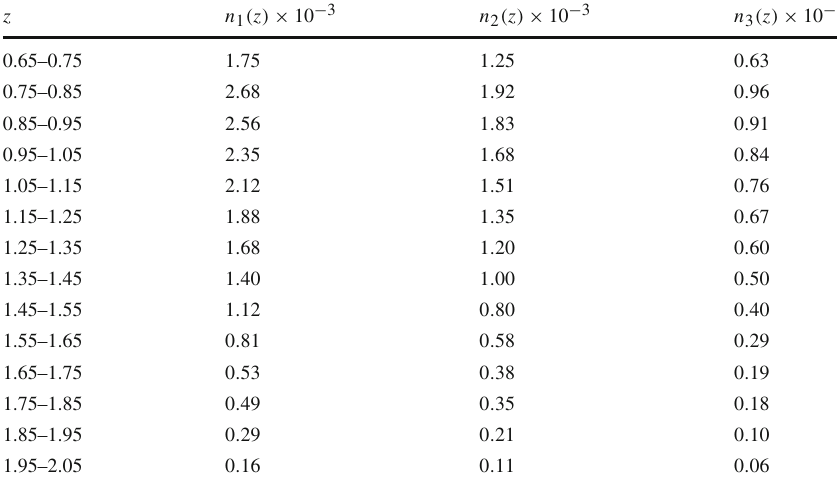
Table 3 Expected galaxy number densities in units of ( h / Mpc ) 3 for Euclid survey z n 1 ( z ) × 10 −